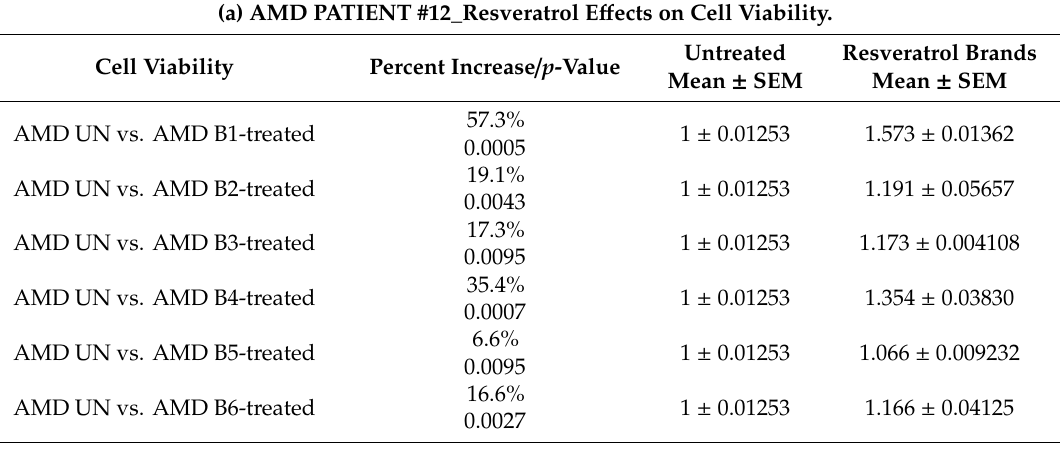
Table 14. E ff ects of resveratrol formulations on cell viability ( a ) and ROS levels ( b ) in AMD patient # 12. (a) AMD PATIENT #12_Resveratrol E ff ects on Cell